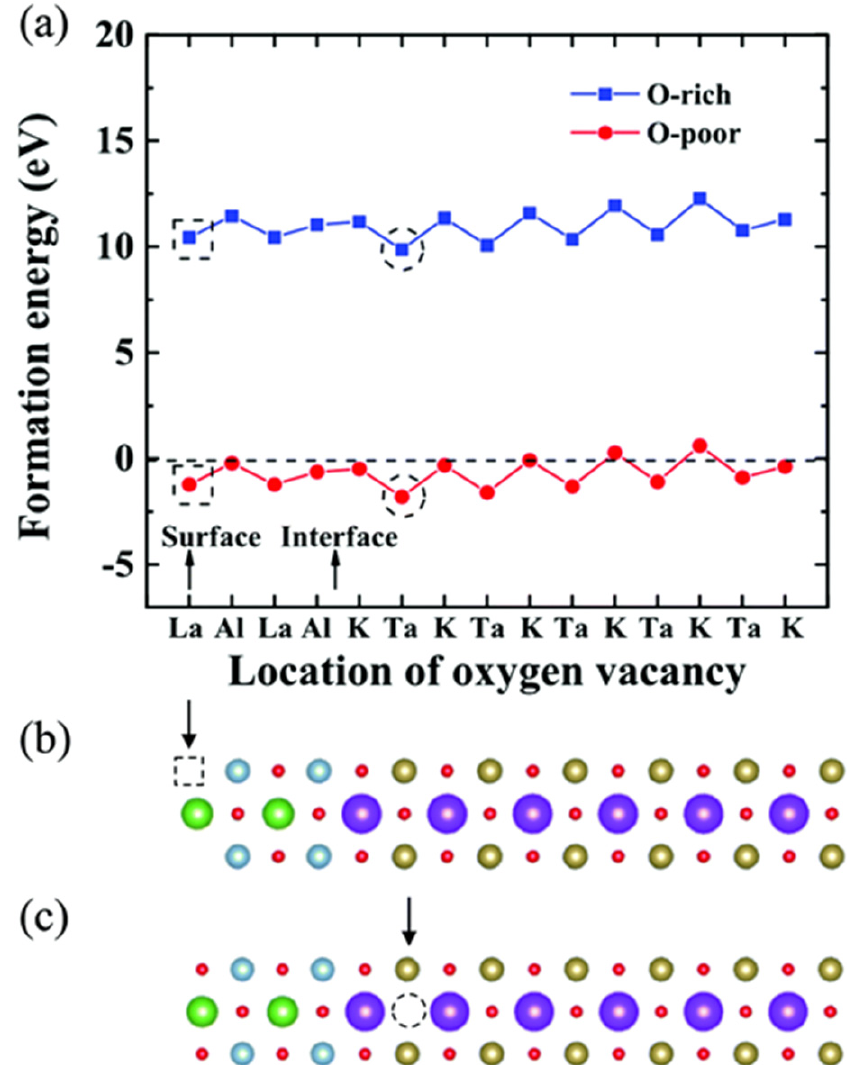
Figure 8. ( a ) Calculated formation energies of oxygen vacancies at different atomic layers in the p-type LaAlO 3 /KTaO 3 under O − rich and O − poor conditions, respectively. Atomic layers of (KO) − , (TaO 2 ) + , (LaO) + , and (AlO 2 ) − are denoted as K, Ta, La, and Al, respectively. ( b ) Partial side view of the LaAlO 3 /KTaO 3 HS-based slab model with an oxygen vacancy on the surface marked by a square. ( c ) Partial side view of the LaAlO 3 /KTaO 3 HS-based slab model with an oxygen vacancy on the TaO 2 layer near the interface marked by a circle